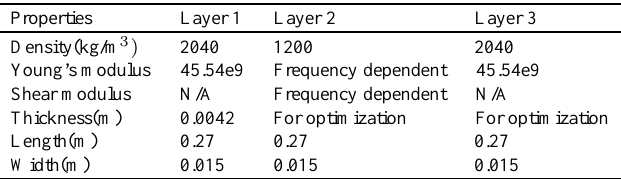
Table 3 Parameters for structure used in